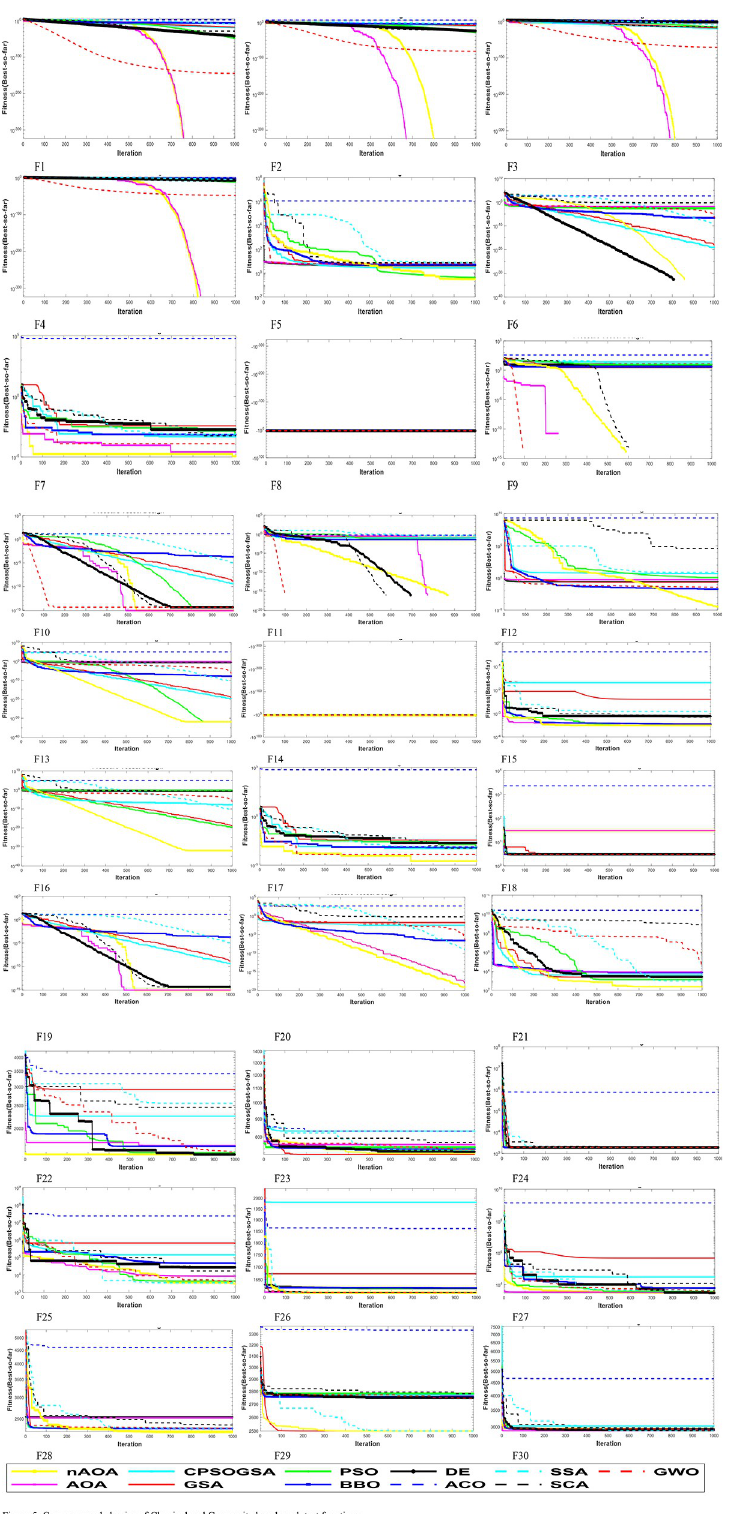
Fig 5. Convergence behavior of classical and composite benchmark test